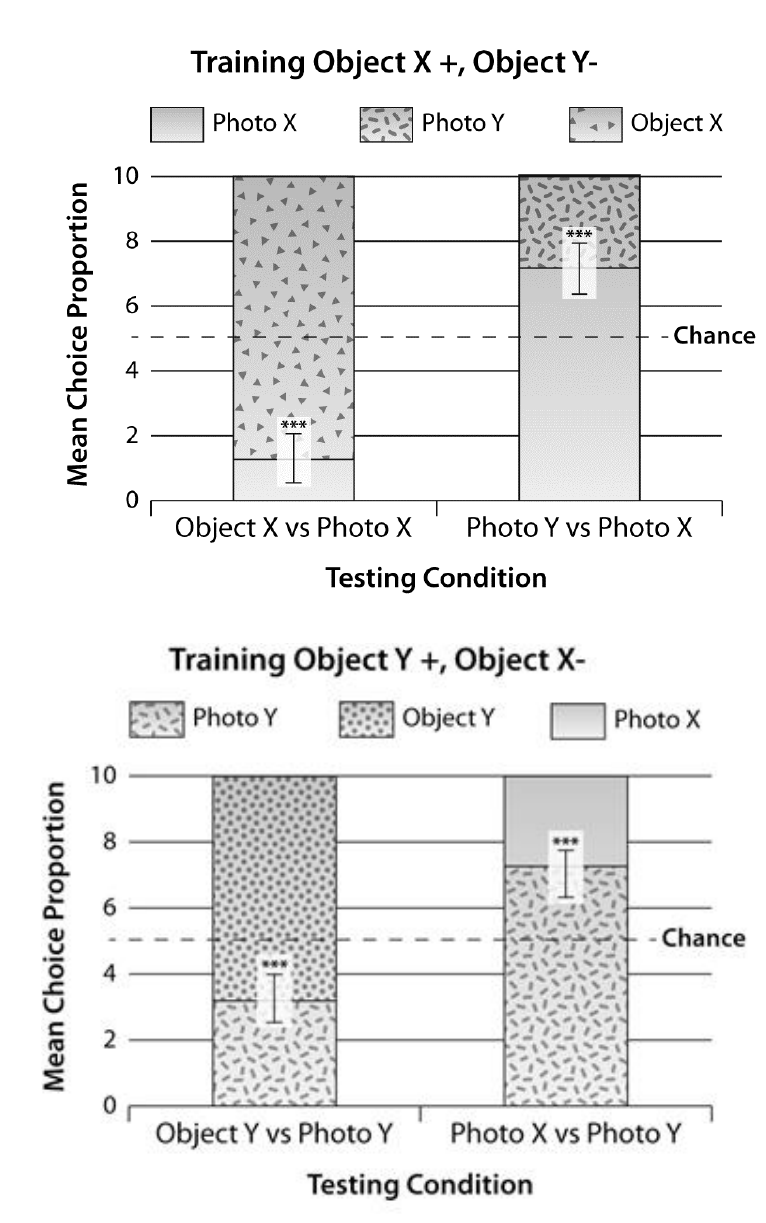
Figure 3 . Choice proportions with standard error bars for tests shown in Table 1 for two groups trained to discriminate between two objects. (A) Object X, shown in Figure 2, was rewarding, while Object Y was unrewarding (B) Object Y, shown in Figure 2, was rewarding while Object X was unrewarding. *** denotes a choice proportion significantly different from chance, p <